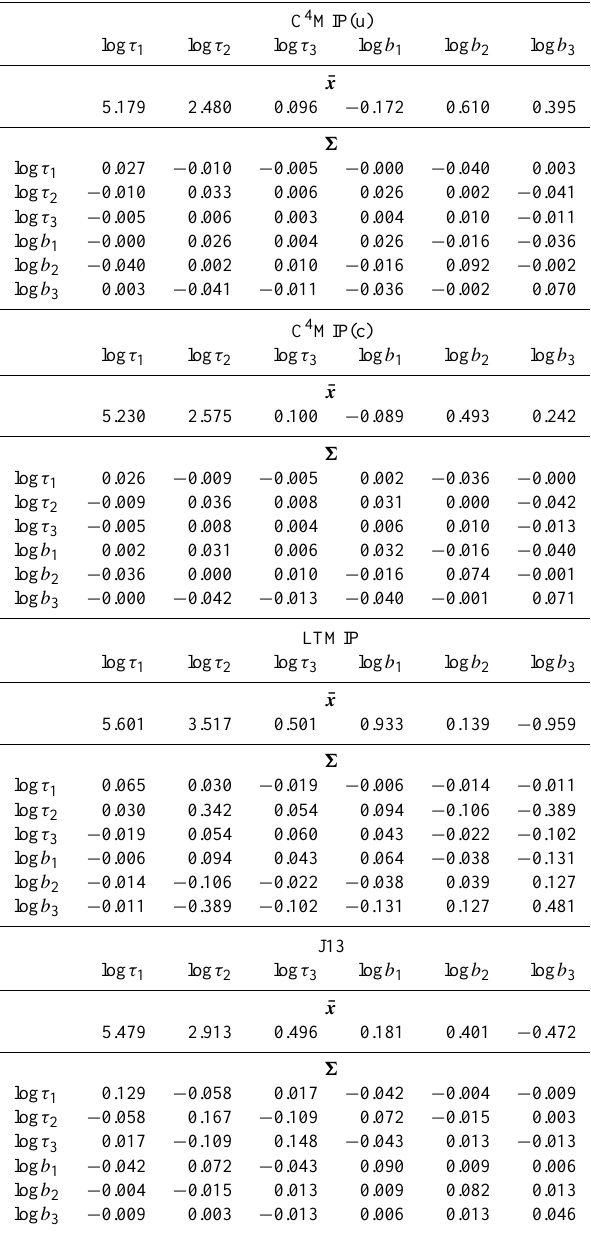
Table 5. Value of mean vector ¯ x and covariance matrix 6 in the IRF CO distributions (see Eq. 16) derived using C 4 MIP, LTMIP, 2 and J13 data. The distribution is for the logarithm of the parameters in IRF CO . 2